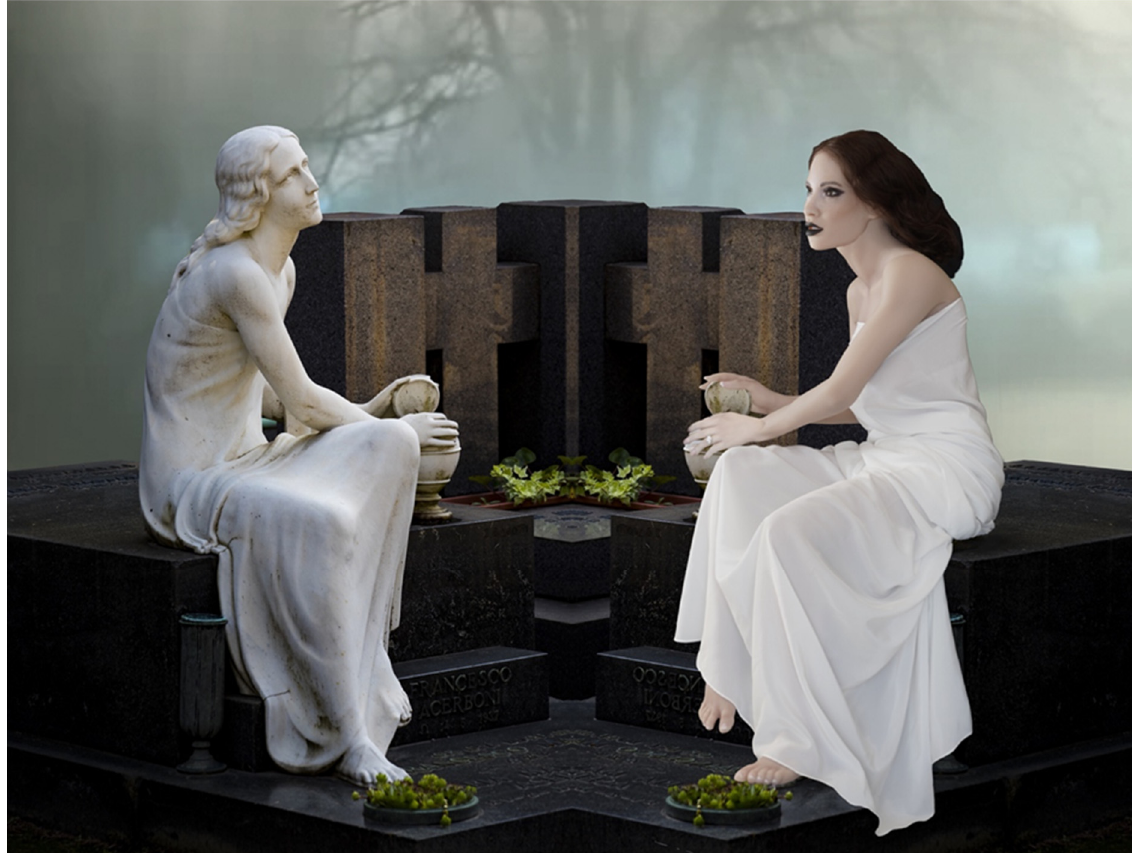
Figure 5. Madeleine + I could not stop for Death. By Graeme Revell, 2022. Photograph, GPT-2/DALL-E2 image and text.